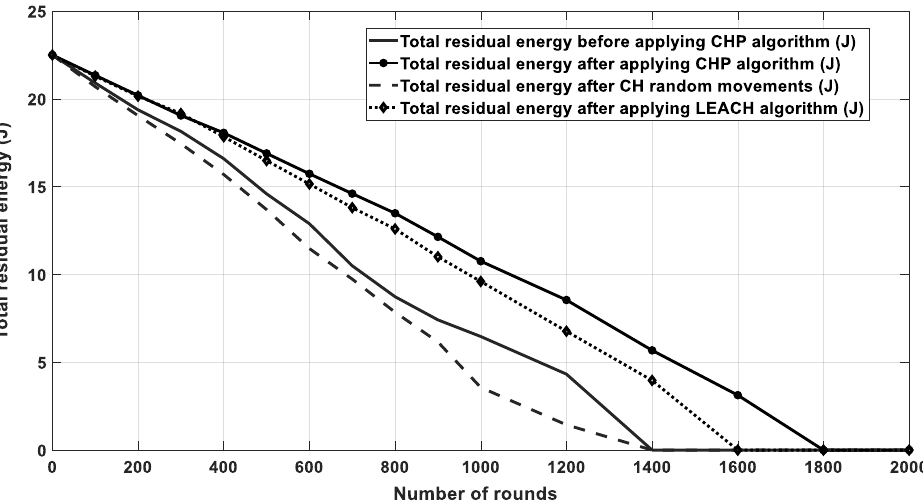
Figure 12. Remaining energy for all the SNs after each round.